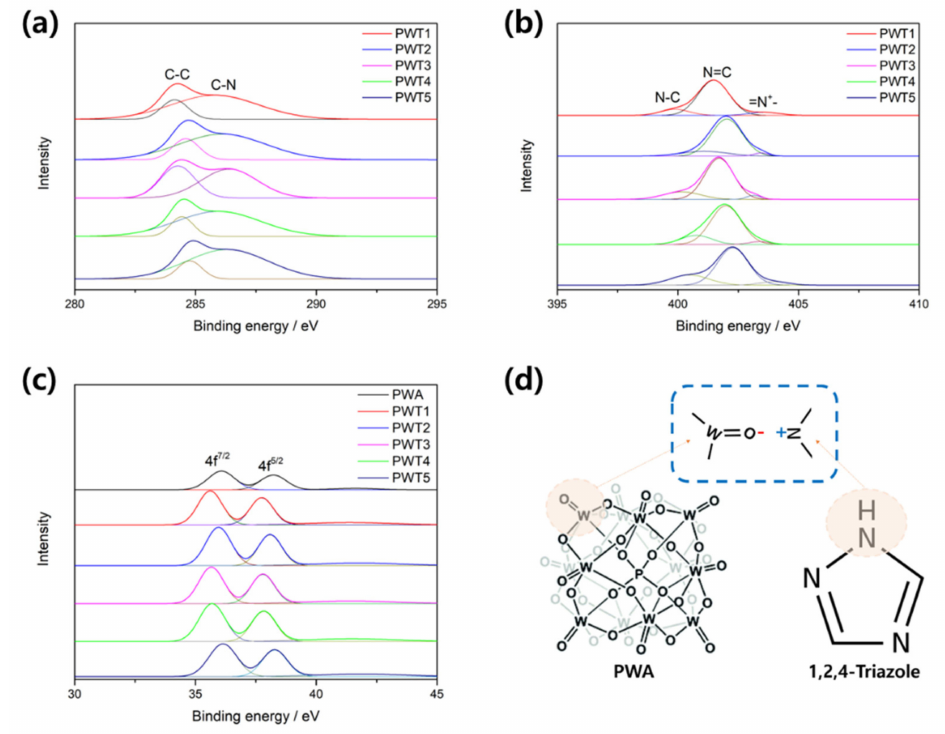
Figure 3. XPS spectra of PWA and the as-synthesized catalysts: ( a ) C 1s, ( b ) N 1s, and ( c ) W 4f. ( d ) Illustration of the plausible chemical bonding in